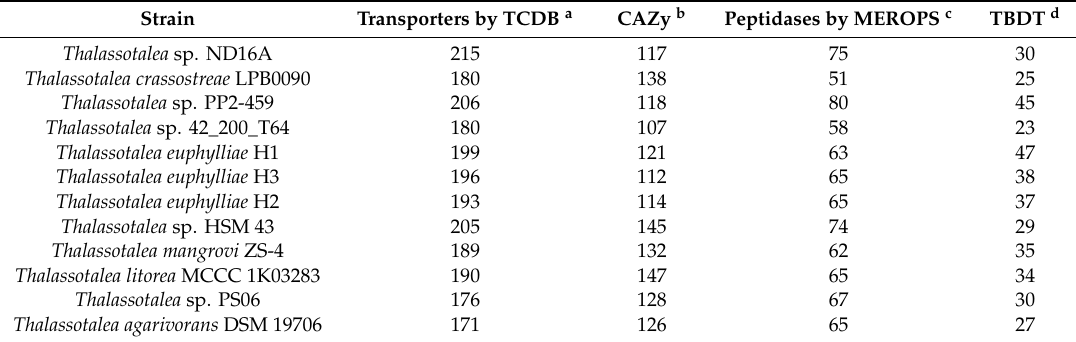
a BLASTp search against the Transporter Classification Database (TCDB), cuto ff : protein similarity ≥ 50%, coverage ≤ 70%. b BLASTp search against the Carbohydrate-active Enzymes Database (CAZy) annotated by the three methods: HMMER, diamond, and Hotpep by dbCAN. DIAMOND: E-Value < 1e-102, hits per query (-k) = 1, HMMER: E-Value < 1e-15, coverage > 0.35, Hotpep: Frequency > 2.6, Hits > 6. c BLASTp search against the peptidase database (MEROPS). d TonB-dependent transporters